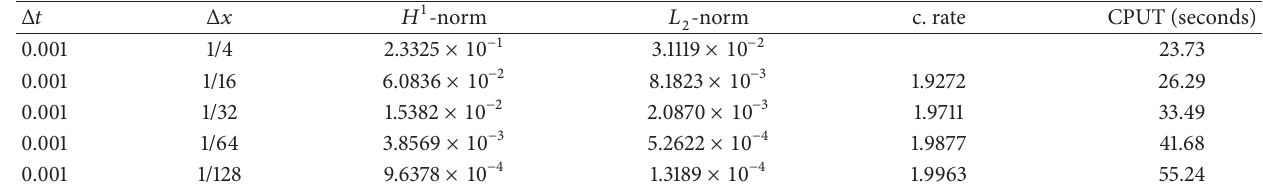
Table 4: Convergence rate in space for (46) with 𝛼 = 0.5 and 𝛽 = 0.25 .